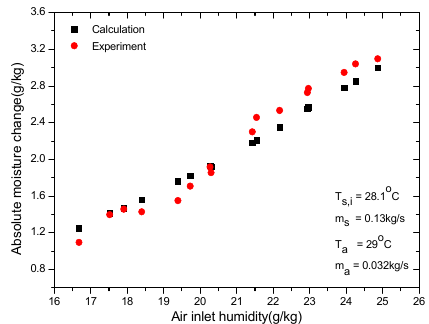
Figure 4. Influence of air humidity on dehumidification